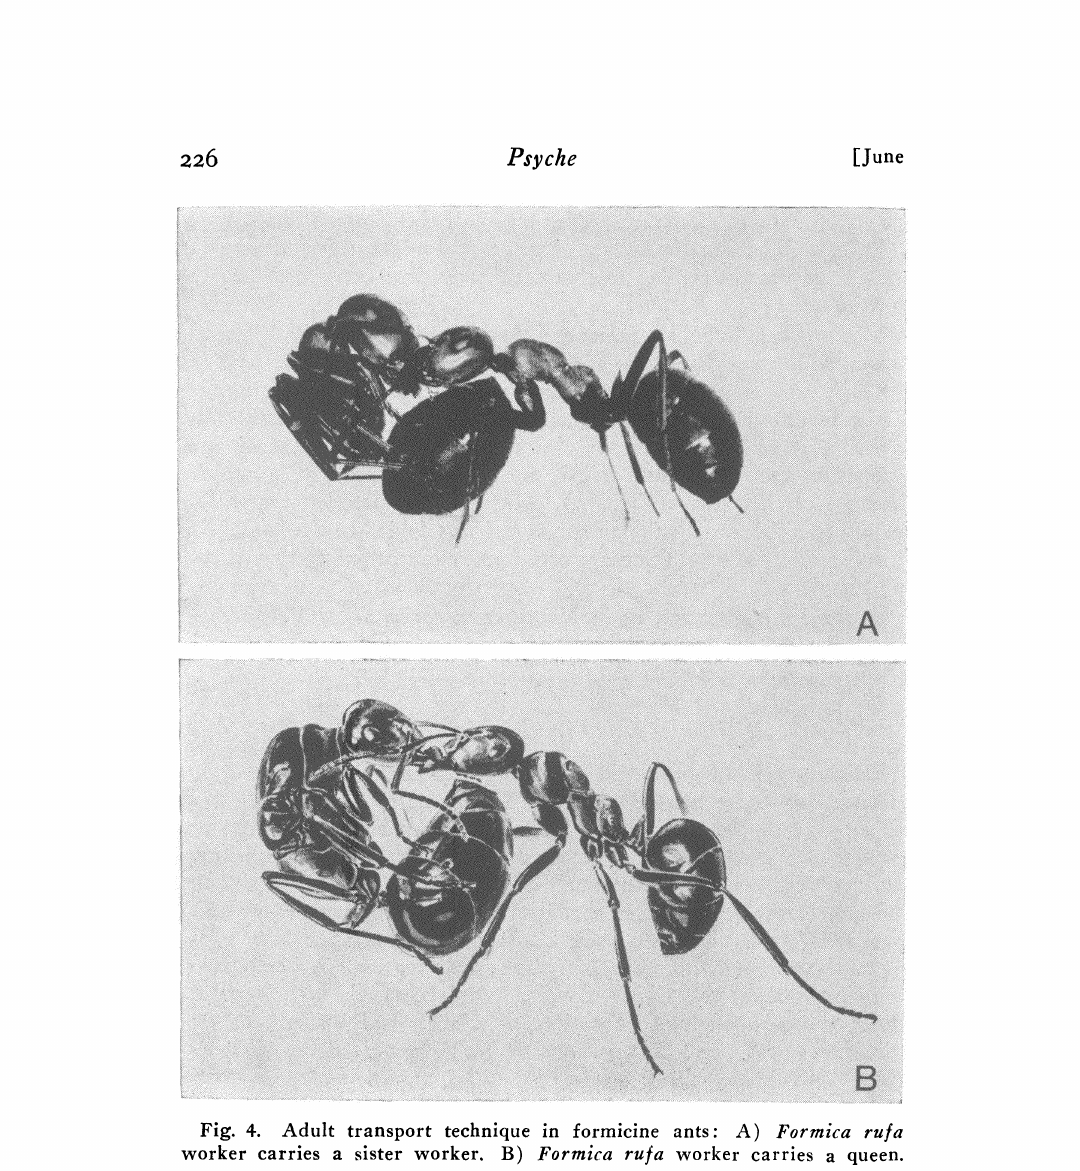
rua worker carries a